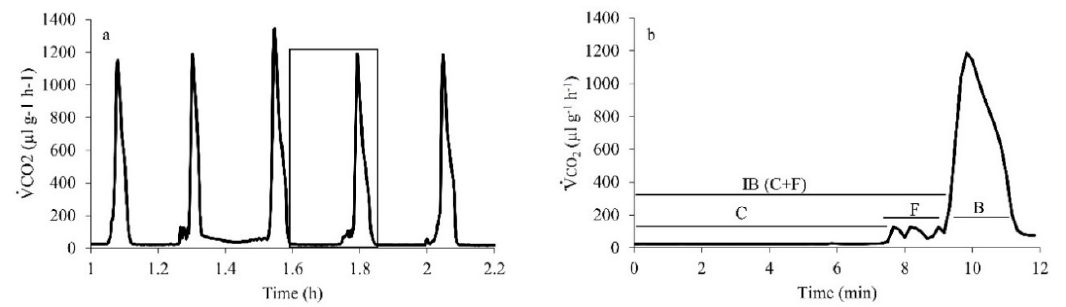
Figure 1. Example of discontinuous gas exchange (DGE) trace for the speckled cockroach. The one DGE cycle in the rectangle in ( a ) is enlarged in ( b ). C is for closed phase, F for flutter, IB is for interburst phase (C and F combined) and B is for burst phase.